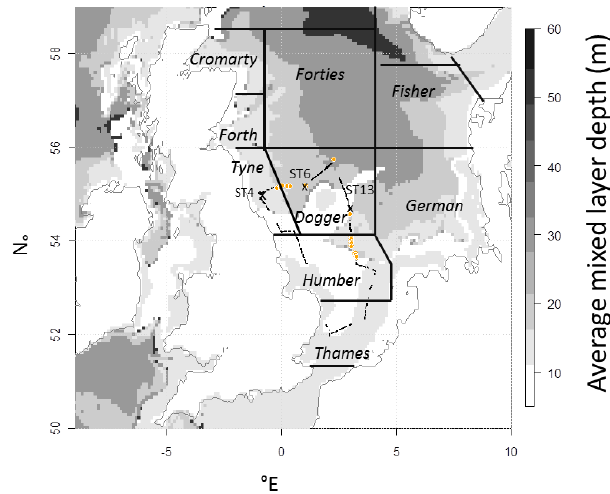
Figure 1. Flow cytometry sampling points superimposed on the mixed layer depth (m) calculated with modelled temperature of the water column from the FOAM AMM7 (average values from 08 to 12 May 2011). Chosen stations for phytoplankton pictures collec- tion with the flow cytometer are labelled (ST: station; ST4, ST6, ST13). Yellow squares correspond to MODIS matching points for non-turbid waters selected between 06:00 and